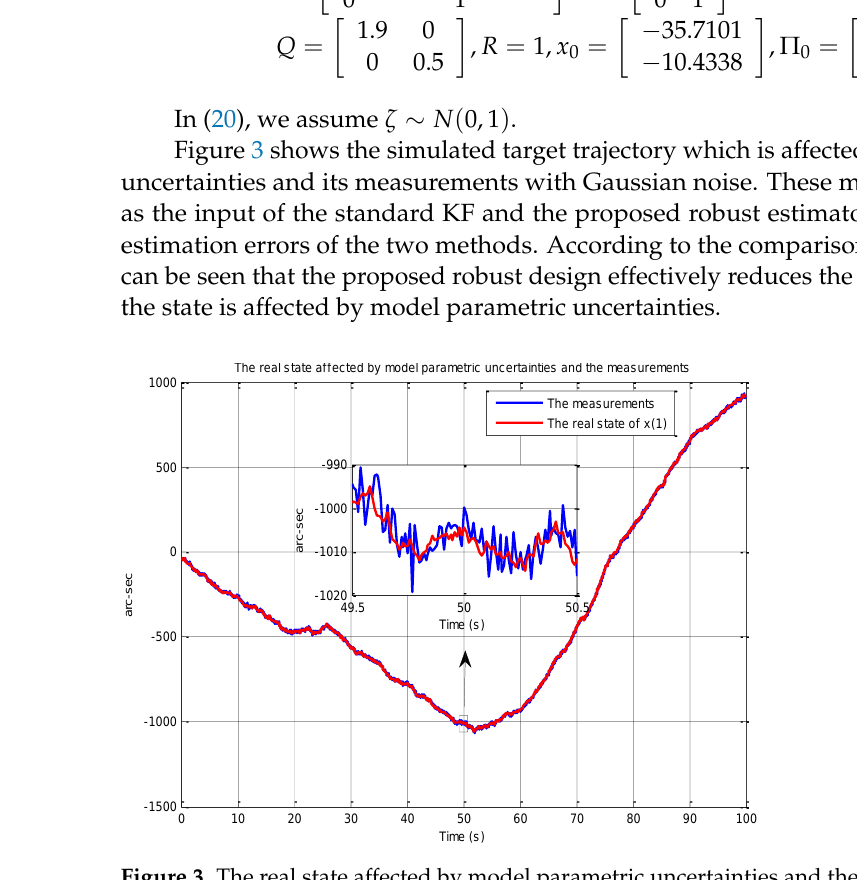
The Kalman filter with nominal parameters The proposed robust design